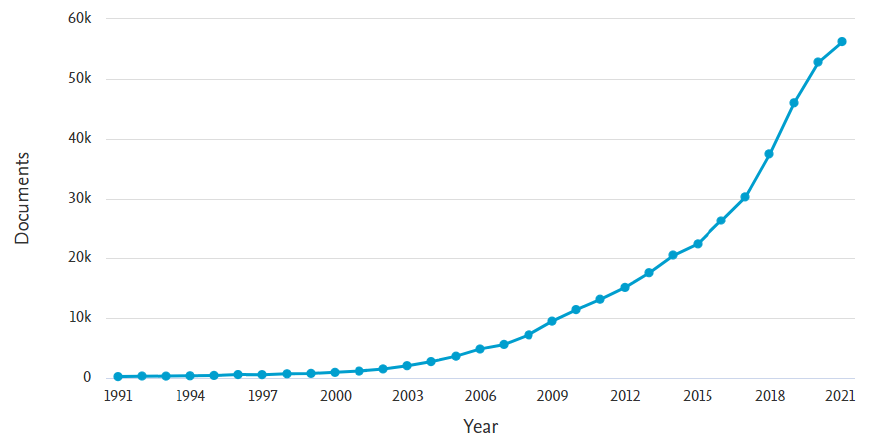
Figure 1. Number of publications related to MOO, 1990–2021 (source: SCOPUS©).